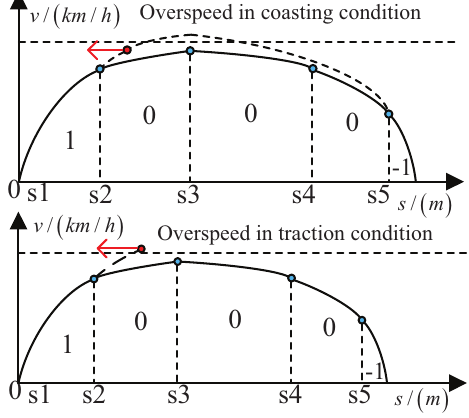
Figure 8. The penalty term Pe 1 of speed is not 0.